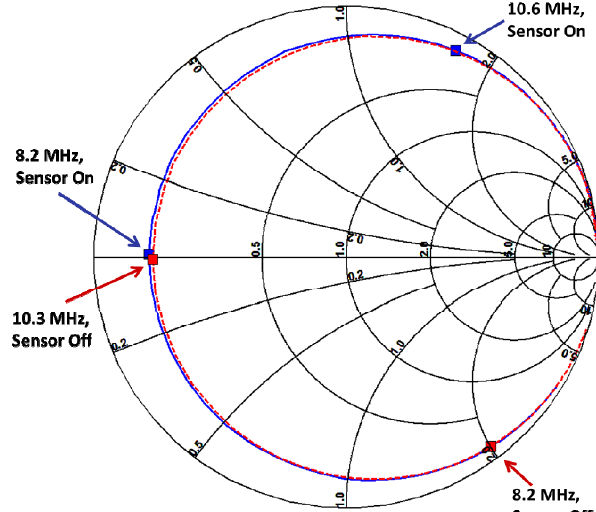
Figure 7. Smith chart showing measured resonance frequency for the interdigital EAS tag equipped with a tilt sensor that is in “on” state, blue (solid) graph, and “off” state, red (dashed)